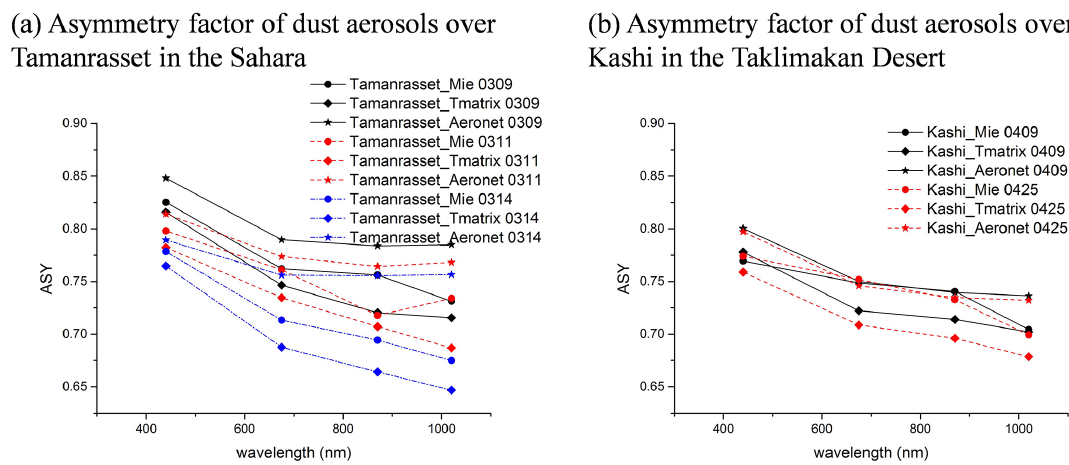
Figure 14. Asymmetry factor of dust aerosols over (a) Tamanrasset in the Sahara and (b) Kashi in the Taklimakan